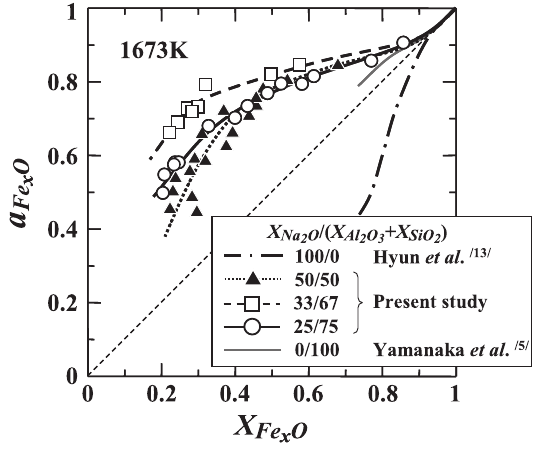
Fig. 3: Relation between a FexO and X FexO for Na 2 O-SiO 2 -Al 2 O 3 -Fe x O slags with an Al